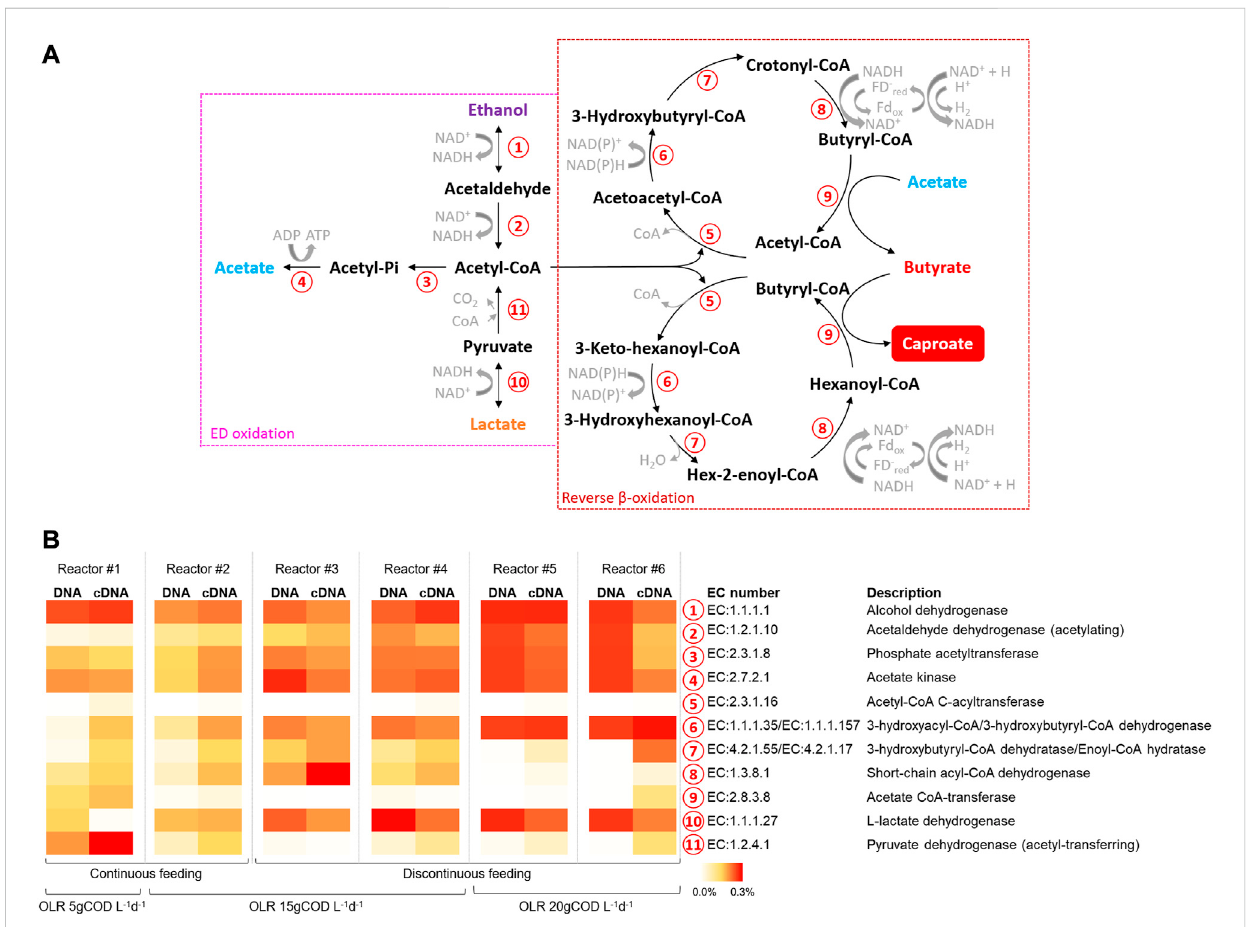
FIGURE 6 (A) Principal metabolic pathways in chain elongation process according to (Wu et al., 2019) (B) Relative abundances of predicted copy number of Enzyme Classi fi cation (EC) numbers related to chain elongation process (as % of total predicted EC